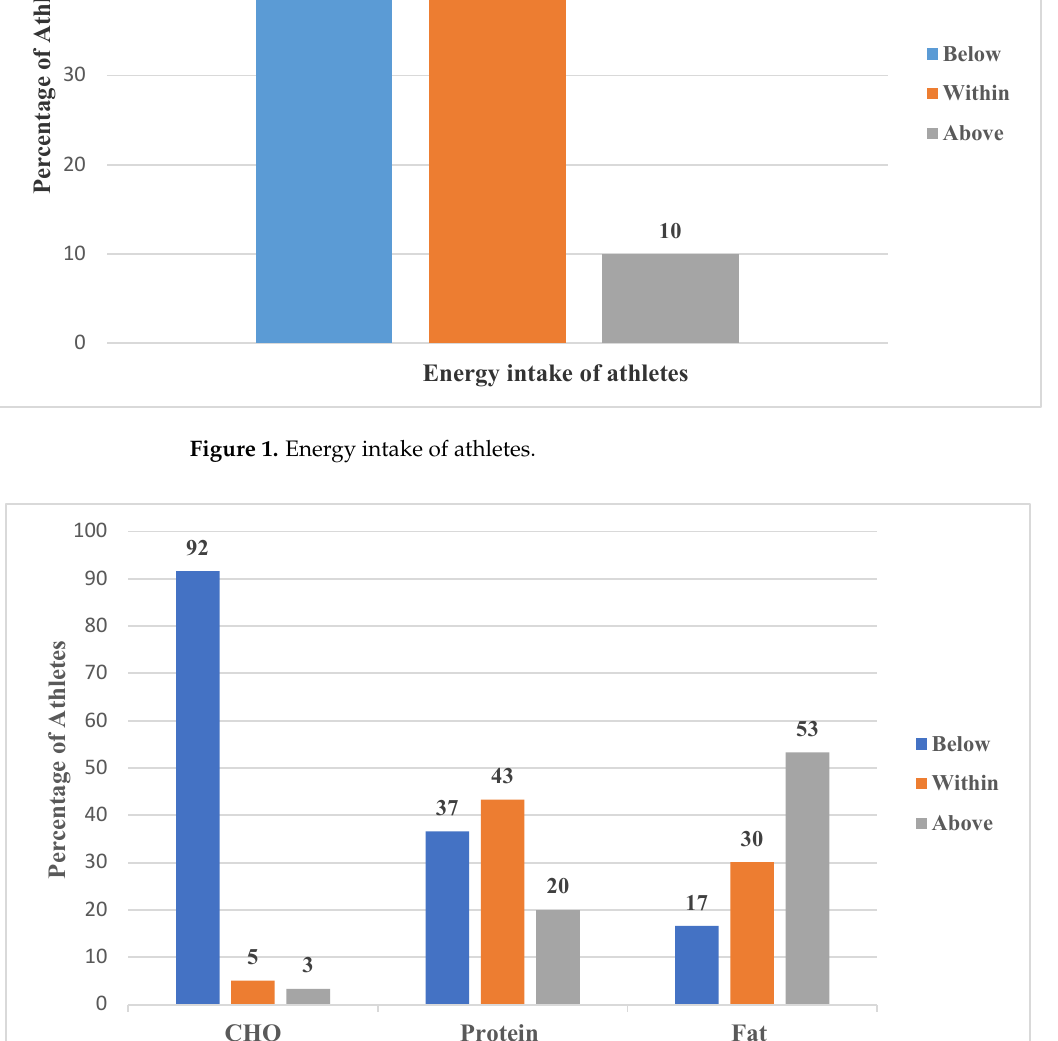
Figure 3. Anthropometry of athletes. Table 4 illustrates the energy and macronutrients intake of the whole group of ath- letes. On the whole, the intake of energy and CHO was suboptimal while that of protein and fat was within and above recommendations, respectively. Table 4. Energy and macronutrients intake of athletes. Variable